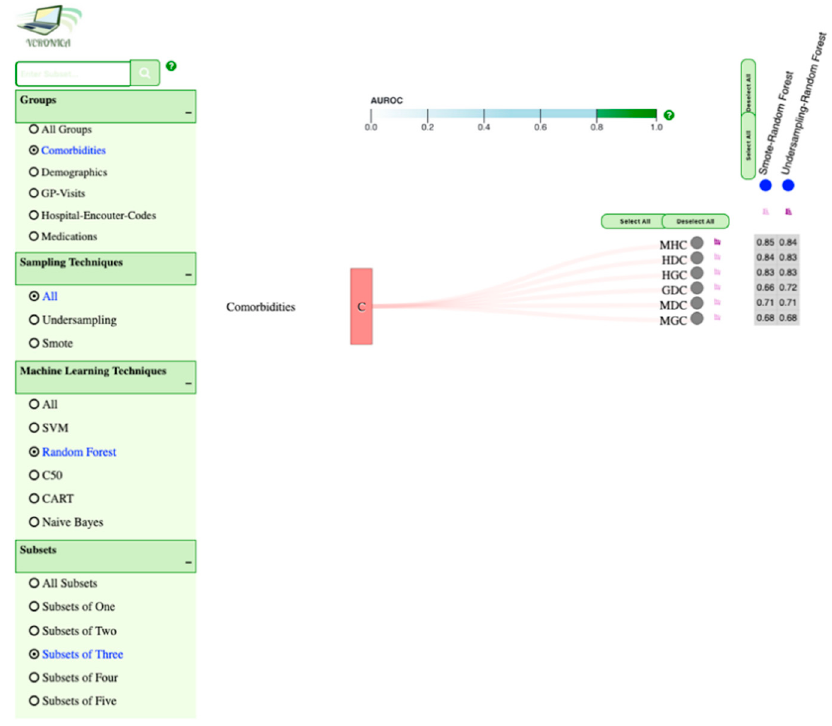
Figure 10. How the system gets updated when users select “ Comorbidities ” , “ Random Forest ” , and “ Subsets of Three ” from “ Groups ” , “ Machine Learning Techniques ” , and “ Subsets ” drop-down menus.